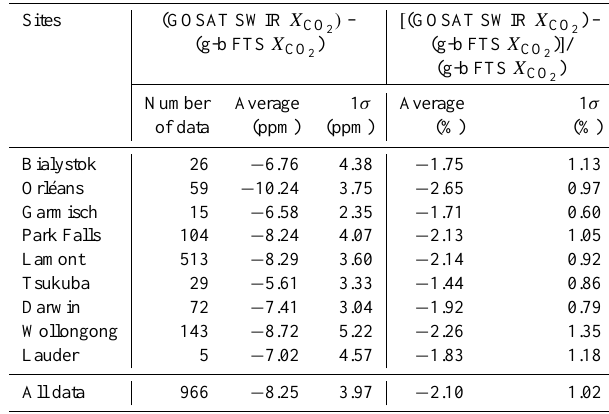
Table B1. Left side: the average and one standard deviation (1 σ) of the difference between GOSAT X CO the nine TCCON sites. Right side: the average and one standard deviation (1 σ) of the difference normalized to g-b FTS X CO in percent). The GOSAT data were retrieved within ± 5 degrees latitude/longitude box centered at each g-b FTS site and the g-b FTS data were the mean values measured within ± 1 h of GOSAT overpass time.